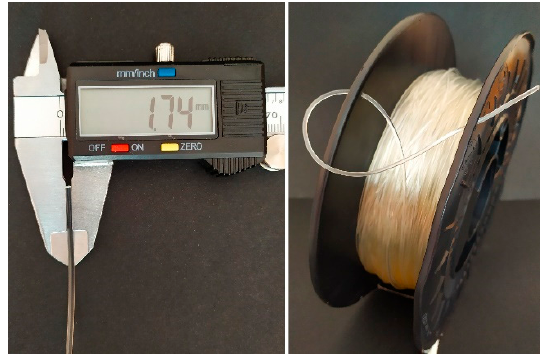
Figure 2. View of obtained TPU_F filament.